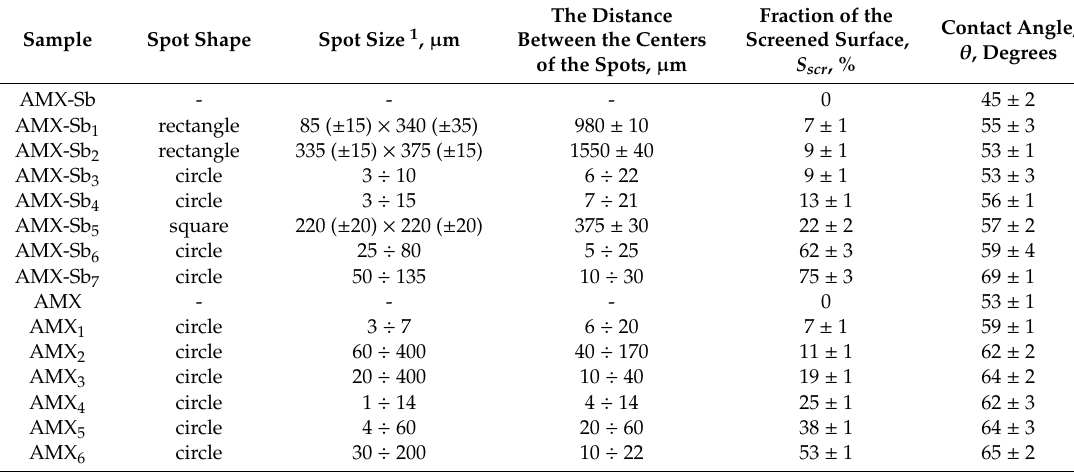
Table 1. Surface characteristics of the membranes under study.